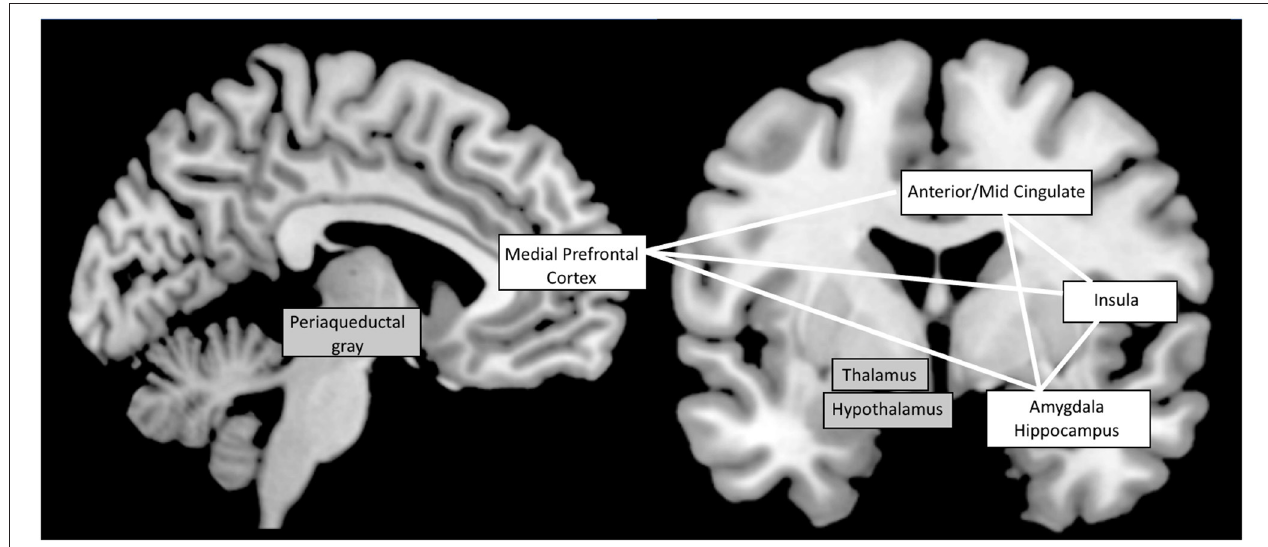
FIGURE 1 | The Central Autonomic Network: most implicated brain regions according to functional neuro-imaging studies (57, 60, 62). Cortical structures are shown on a white background while subcortical structures are on a gray background. White lines symbolize the functional connectivity between cortical regions.